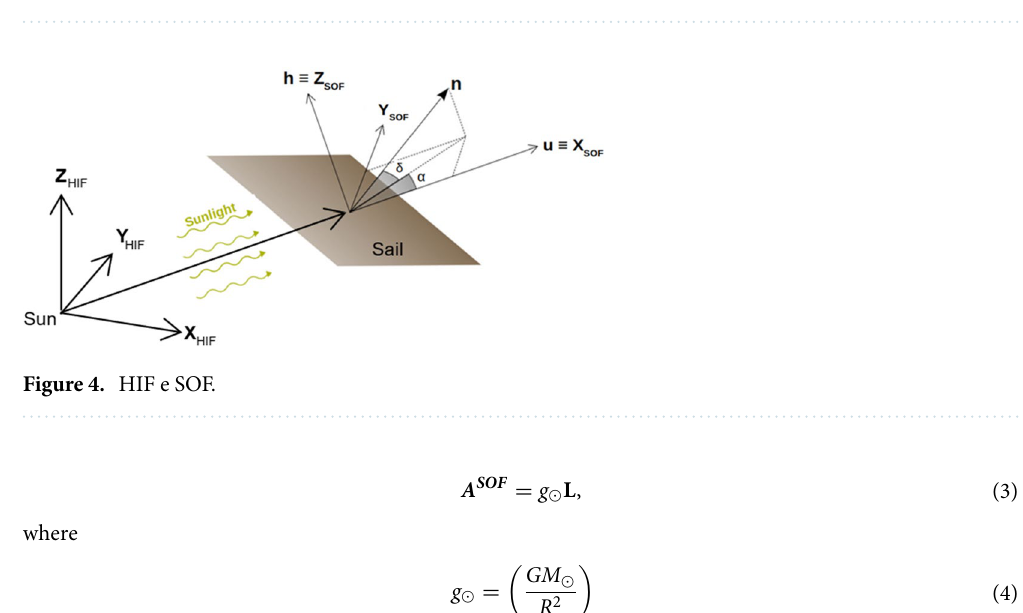
Figure 3. ( a ) TGE with maximum reach in the geocentric reference frame. ( b ) The same TGE in the heliocentric reference frame.